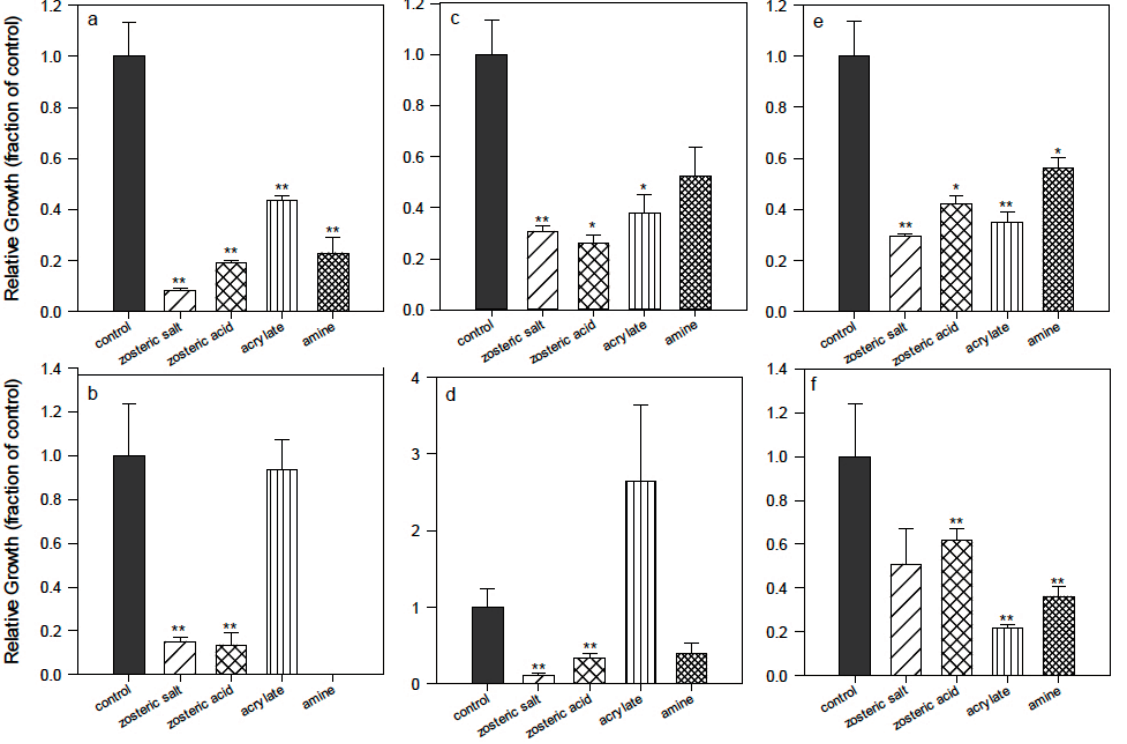
Figure 4. Comparison of basic activity of surfaces from acrylate (1) oligomer, from amine (4) oligomer, from acrylate mixed with zosteric acid powder (ZA) or with zosteric sodium salt powder (ZAS). Pseudomonas aeruginosa ( left ), Staphylococcus aureus ( middle ), Staphylococcus epidermidis ( right ). ( a ), ( c ), ( e ) = bacteria suspended in the supernatant media; ( b ), ( d ), ( f ) = bacteria attached to the control (polystyrene) or polymer surface. * , difference in values significant at p ≤ 0.05, ** difference in values significant at p ≤